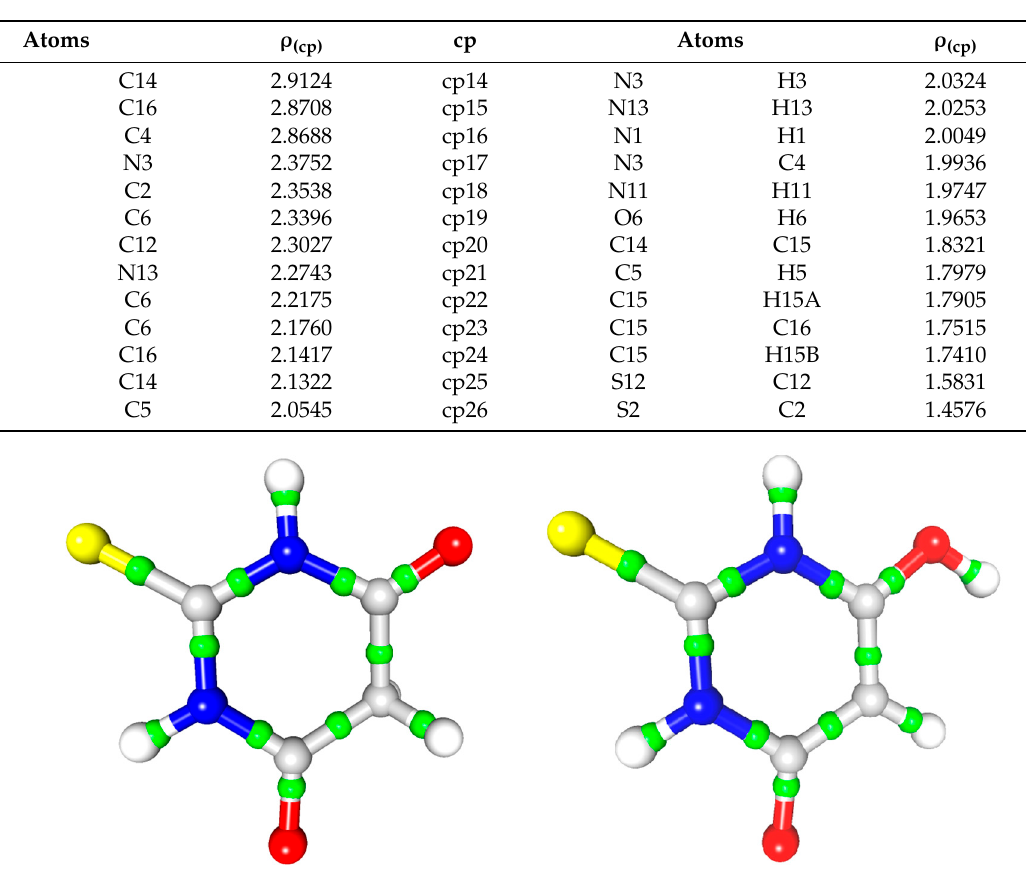
Table 2. Selected characteristics of BCP for TBA molecules.